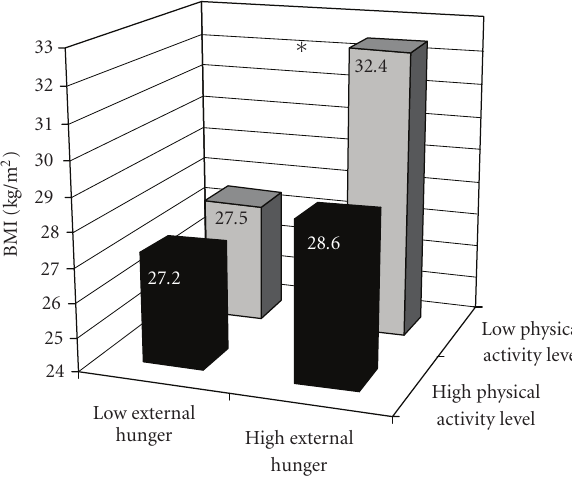
Figure 2: Body mass index in the group of postmenopausal women is separated on the basis of external hunger and physical activity participation. Lower and higher physical activity participation are presented in grey and in black respectively. ∗ indicats a significant di ff erence in women with lower external hunger and lower physical activity participation. For lower physical activity participation and lower external hunger, n = 43, and mean BMI = 27.5 ± 0.8kg/m 2 ; for lower physical activity participation and higher external hunger, n = 21, and mean BMI = 32.4 ± 1.1 kg/m 2 ; for higher physical activity participation and lower external hunger, n = 31, and mean BMI = 27.2 ± 1.3 kg/m 2 for a higher physical activity participation and higher external hunger, n = 18, and mean = 28.6 ± 1.1 kg/m 2